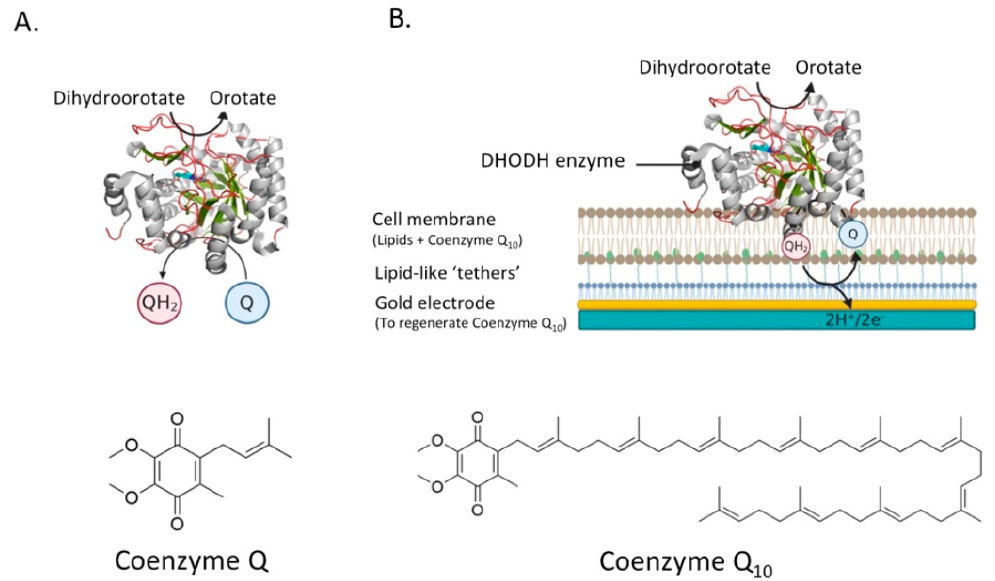
Figure 8. The reactions catalyzed by DHODH and a schematic overview of the proposed system to analyze the activity of DHODH. ( A ) DHODH catalyzes the oxidation of dihydroorotate (DHO) to orotate. The two electrons that are removed in that reaction are transferred to coenzyme Q via a flavin mononucleotide (FMN). ( B ) The activity of DHODH could be monitored using a planar tethered lipid bilayer system, homologous to that reported in Godoy-Hernandez et al. (2019). In this system, a gold electrode is connected to a cell membrane containing the DHODH enzyme. QH 2 that is generated after the reduction of coenzyme Q by DHODH is regenerated at the gold electrode. The two electrons coming from that reaction will generate a current in the electrode. 3D structural cartoons showing the Homo sapiens DHODH (PDB:2PRH) [109] were rendered using PyMol and the figure compiled using BioRender.com [8].